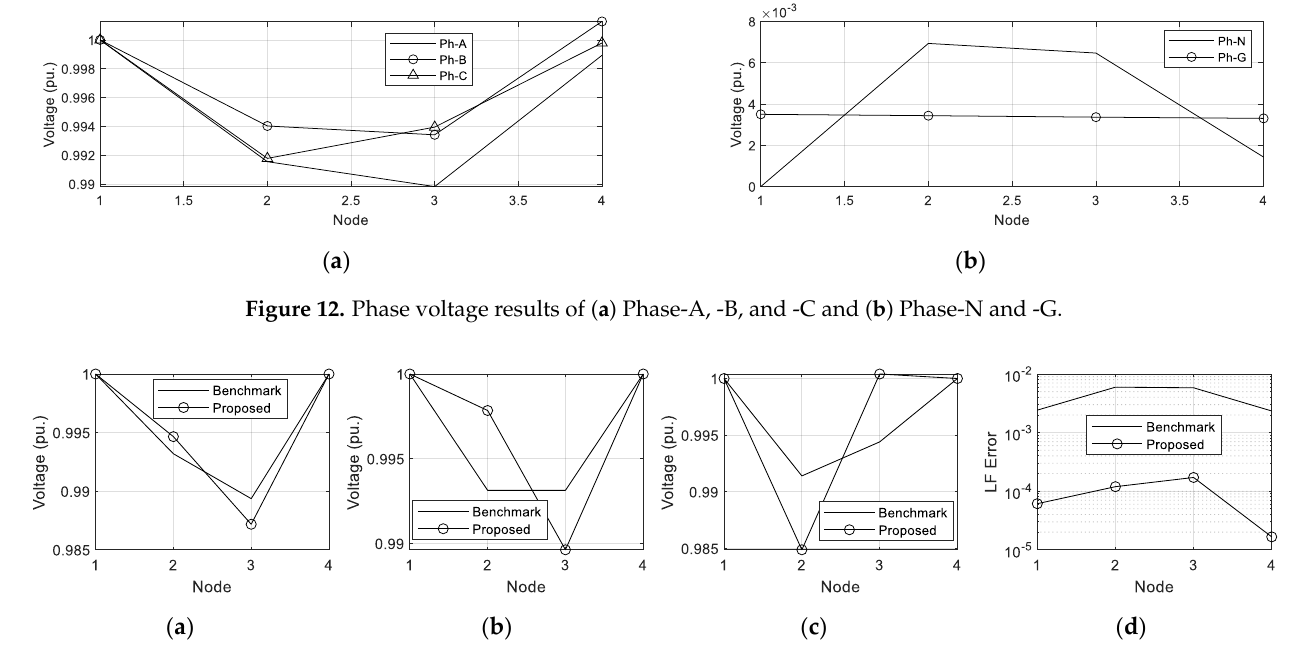
Figure 13. Comparison between benchmark and proposed methods at ( a ) Phase − AN, ( b ) Phase − BN, ( c ) Phase − CN, and ( d ) errors in LF results.